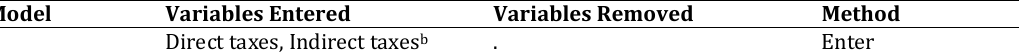
Table 5: Conceptual variables in the OLS model